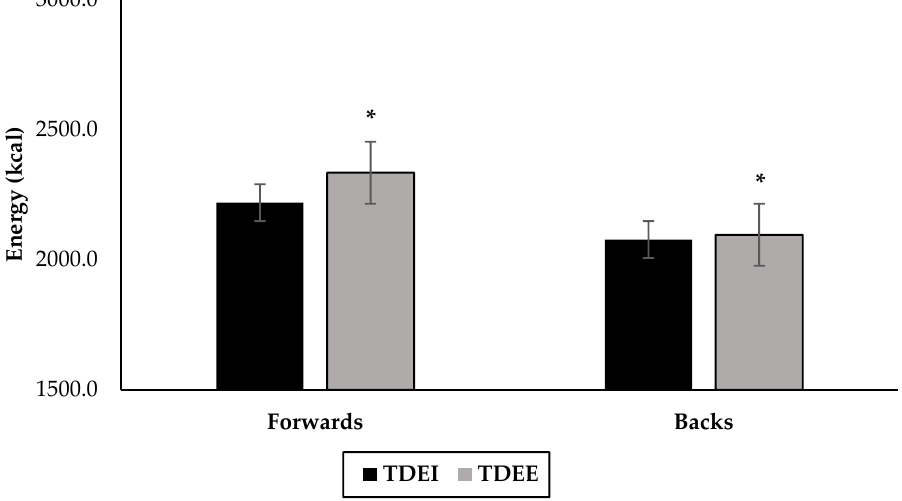
Figure 1. Average weekly values for total daily energy intake (TDEI) and total daily energy expendi- ture (TDEE) in both forward and back positions ( n = 15, 9 forwards, 6 backs). * Significant difference from TDEI, same position ( p < 0.01).